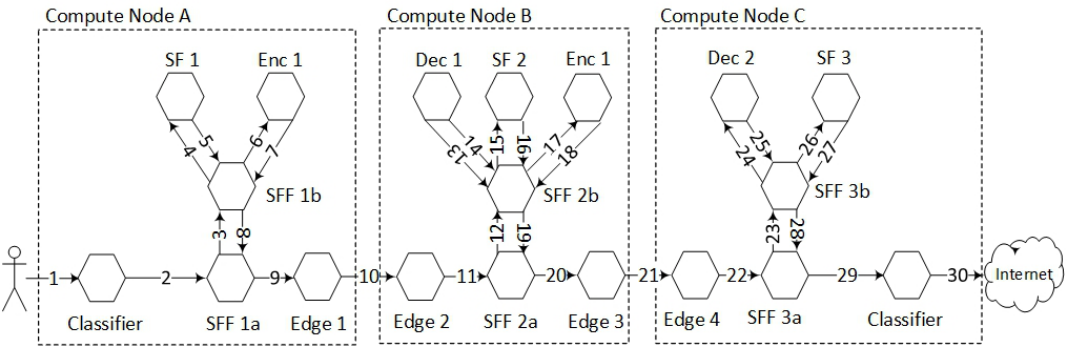
Figure 6. Service plane topology.